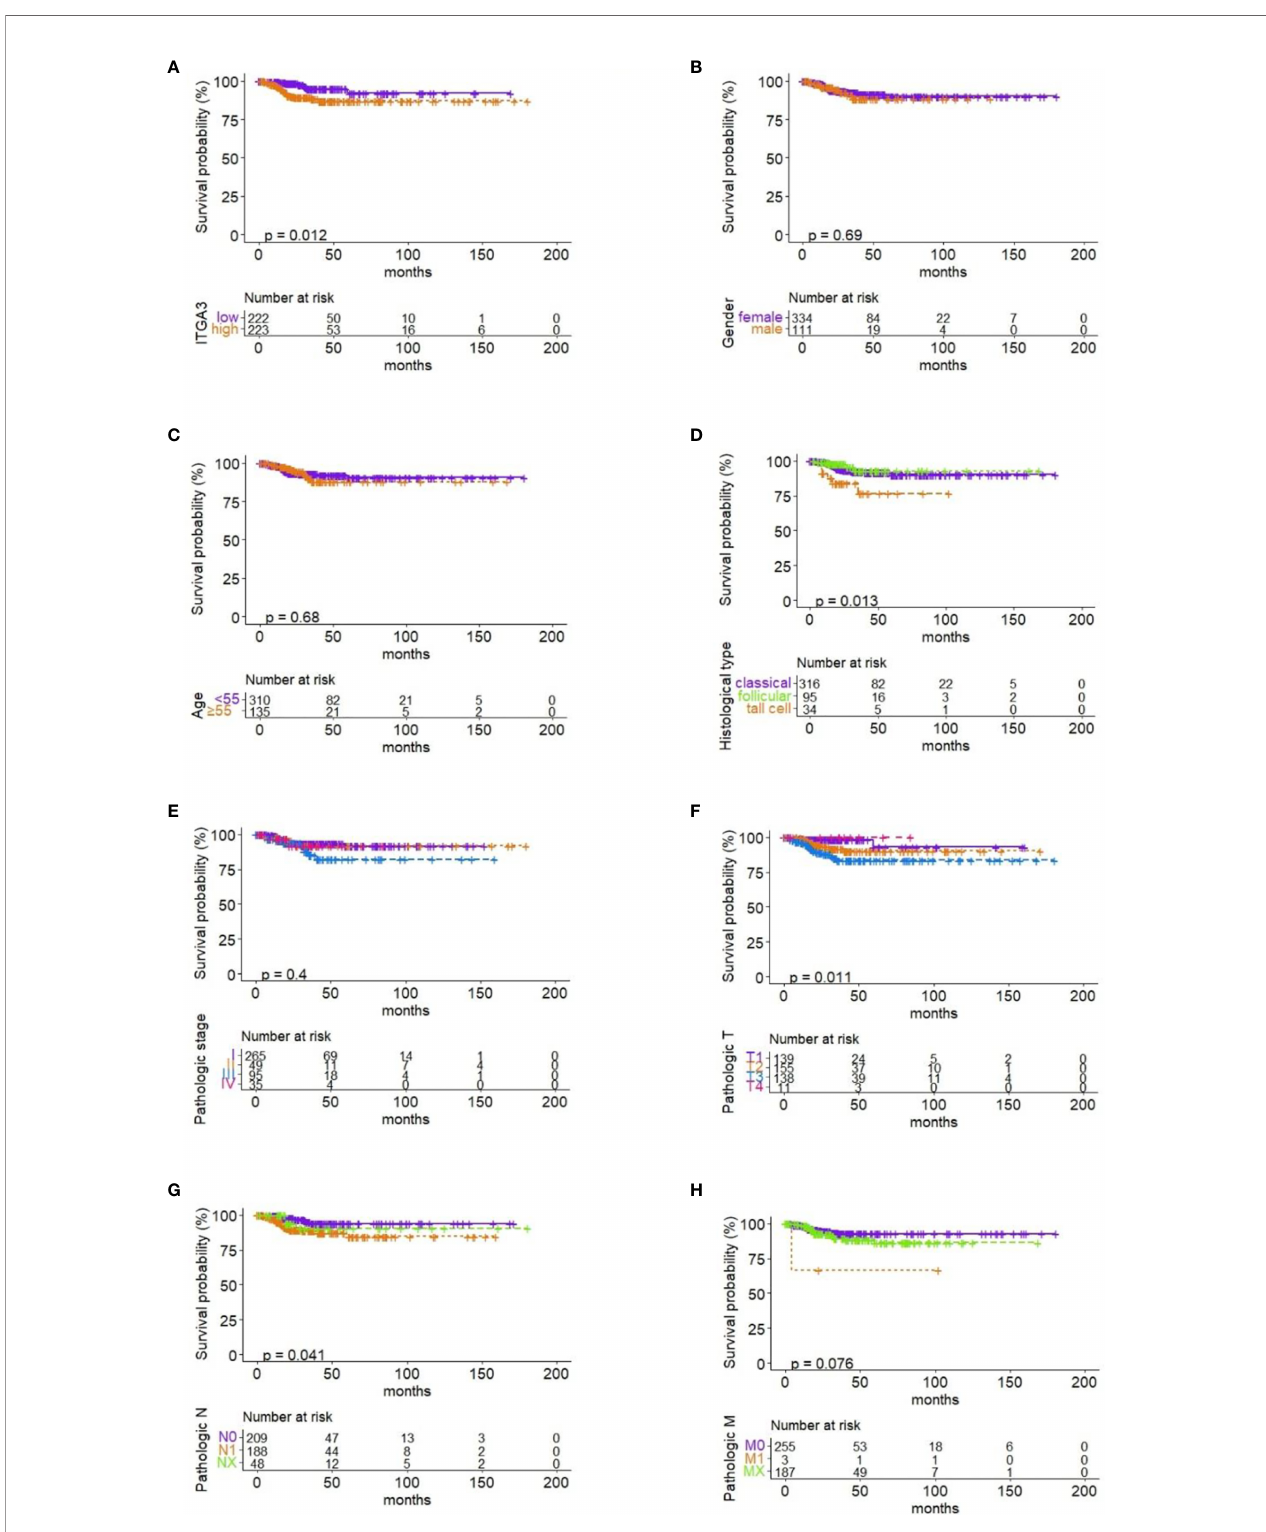
FIGURE 5 | Correlation between RFS and ITGA3 expression and clinicopathologic characteristics. (A) Survival analysis of RFS by ITGA3 expression with the median level. (B) Survival analysis of RFS by gender. (C) Survival analysis of RFS by age. (D) Survival analysis of RFS by pathologic subtype. (E) Survival analysis of RFS by pathologic stage. (F) Survival analysis of RFS by pathologic T. (G) Survival analysis of RFS by pathologic N. (H) Survival analysis of RFS by pathologic